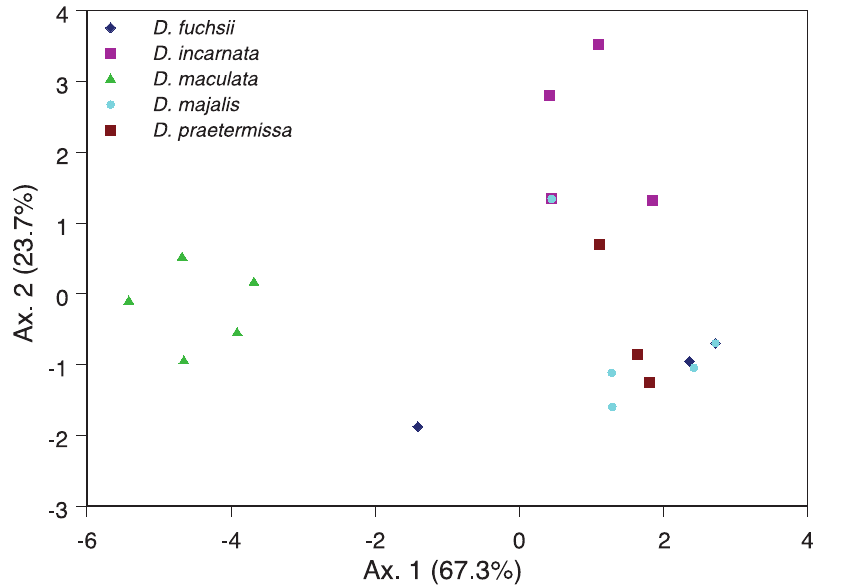
Figure 5. Discriminant analysis (DA) plots comparing mycorrhizal spectra in five Dactylorhiza species sampled in 26 populations in Belgium.